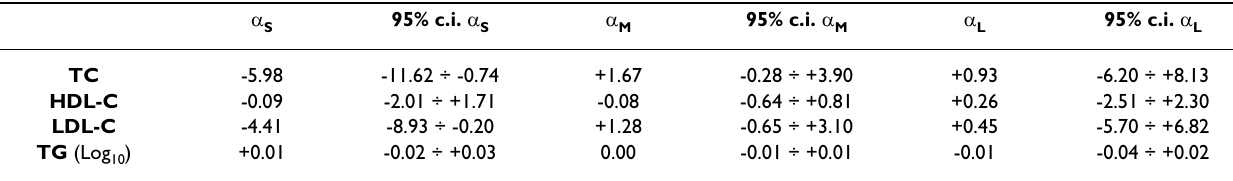
Table 5: Allele average effects α S , α M and α L estimated for S , M and L alleles respectively of the 3'VNTR-APOB polymorphism in the whole sample of healthy subjects after normalization for age, sex and BMI (computed according to the formula: BMI = weight [Kg]/ height [m 2 ])